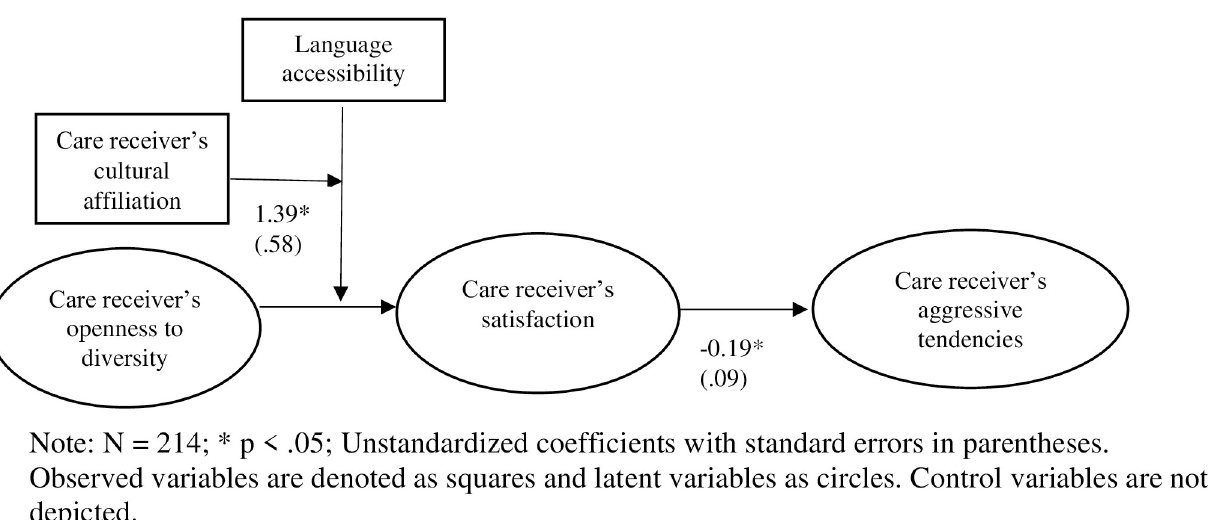
Fig 1. Structural equation analysis for the research